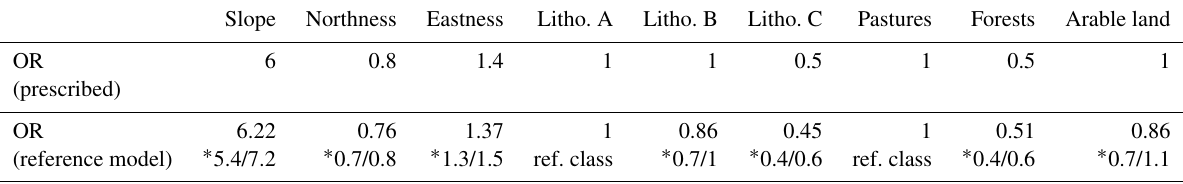
Table 1. Prescribed relationship between the predictors and the response variable for the synthetic data set expressed as odds ratios (OR) (first row). The model estimate (bottom row) was based on the synthetically generated landslide sample (see Fig. 3f) and a logistic regression model trained with the predictors slope, northness, eastness, lithology, land cover. OR for the predictor slope relate to a slope angle increase of 10 ◦ , OR for both components of slope aspect (northness, eastness) to an orientation change of 45 ◦ . Slope Northness Eastness Litho. A Litho. B Litho. C Pastures Forests Arable